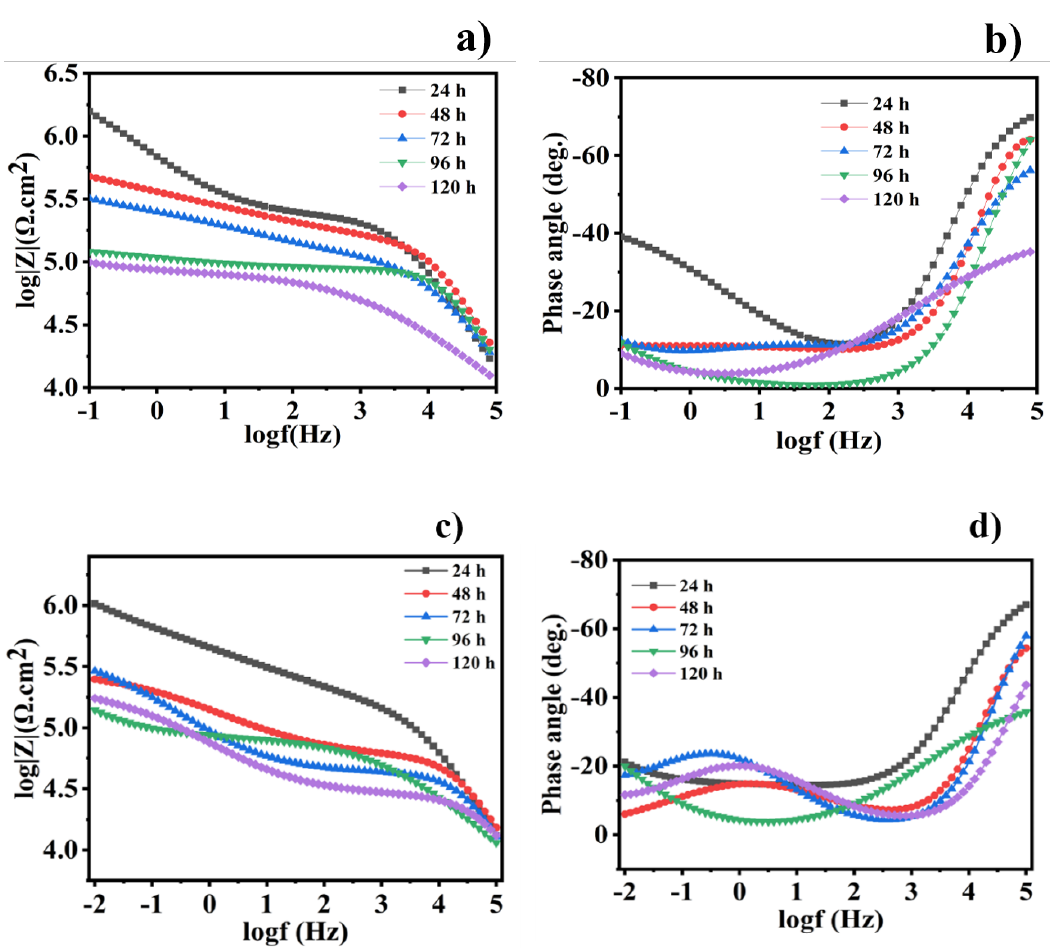
Figure 8. ( a , c ) Bode and ( b , d ) the corresponding phase angle plots for the scratched blank and epoxy / CeO 2 coatings, respectively, afterdi ff epoxy/CeO 2 coatings, respectively, after different immersion times in 3.5 wt. % NaCl at room temperature.